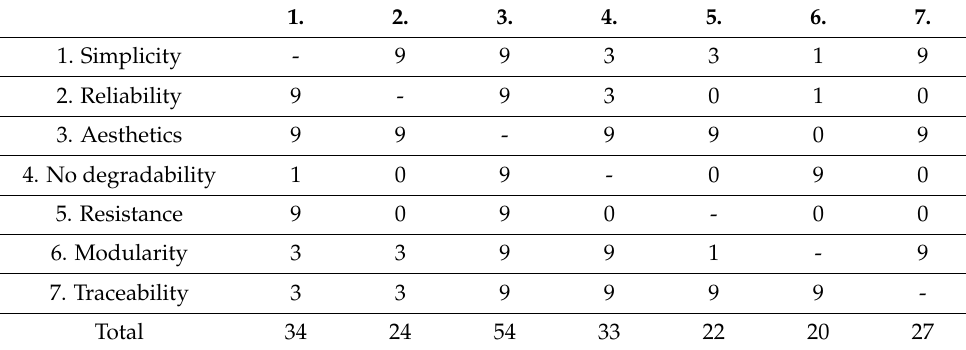
Table 1. Dependence/Independence